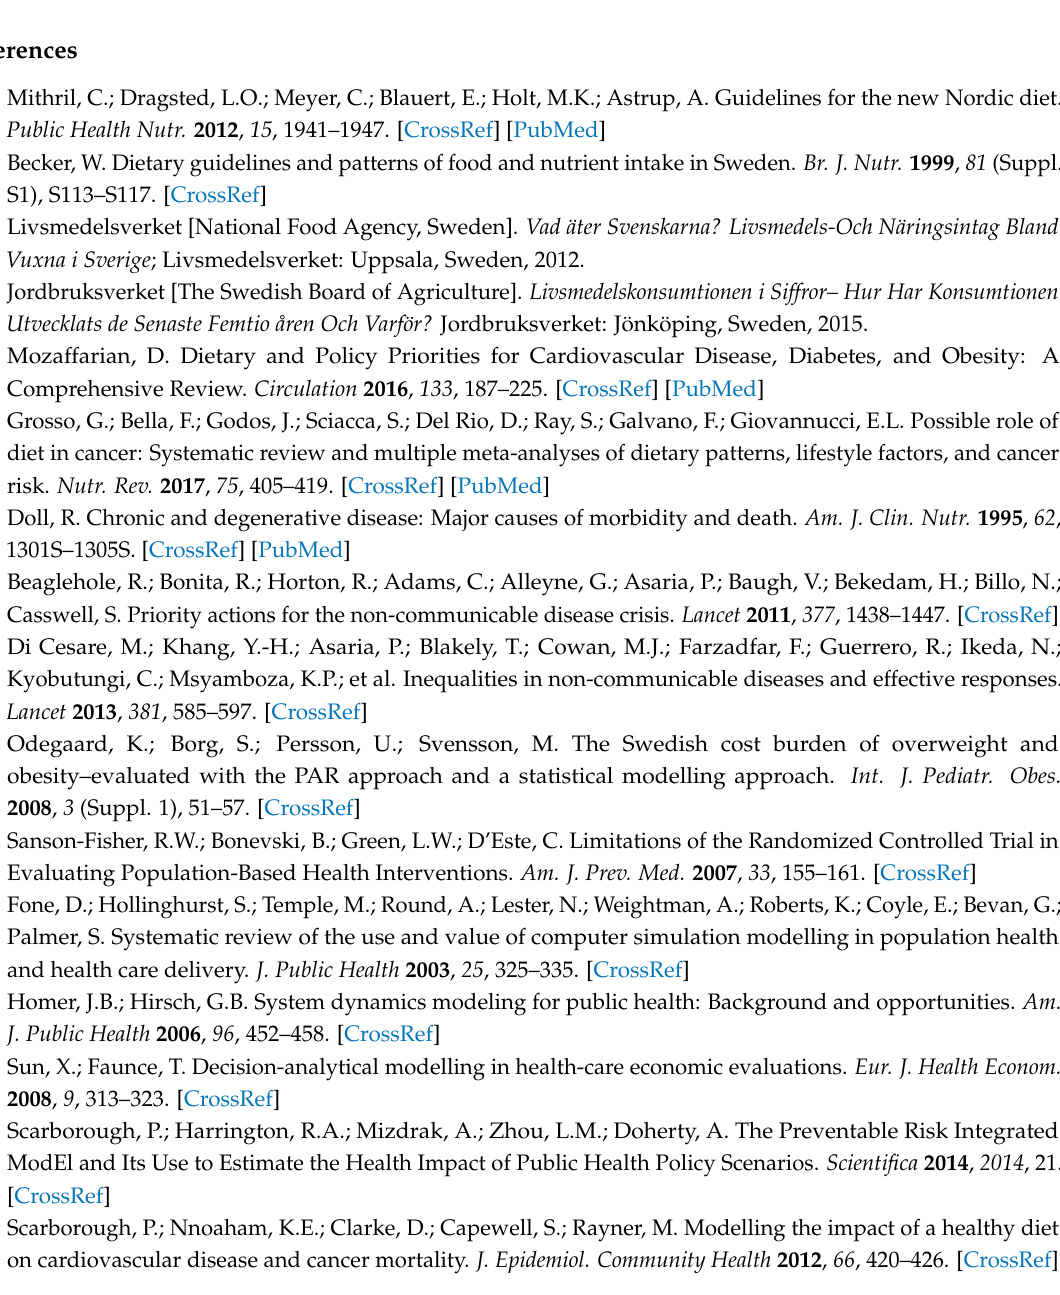
Table S1: Age-group and sex-specific mean (standard deviation) dietary intake incorporated in the PRIME model. Author Contributions: Conceptualization, S.S., P.S. and U.-G.G.; methodology, S.S., P.S., J.N., I.M.,